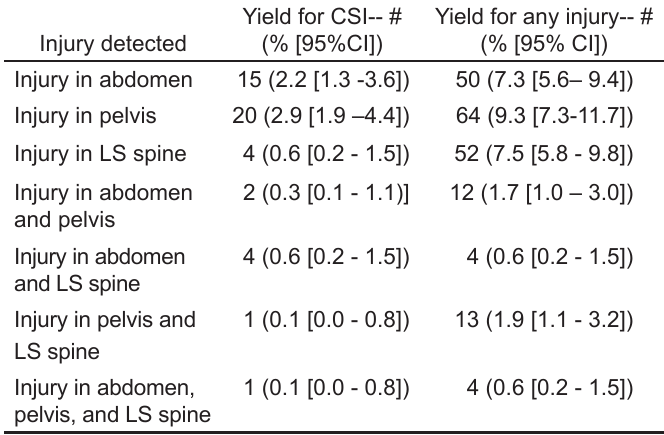
Table 4. Yields of abdominal and pelvis computed tomography (N = 689).